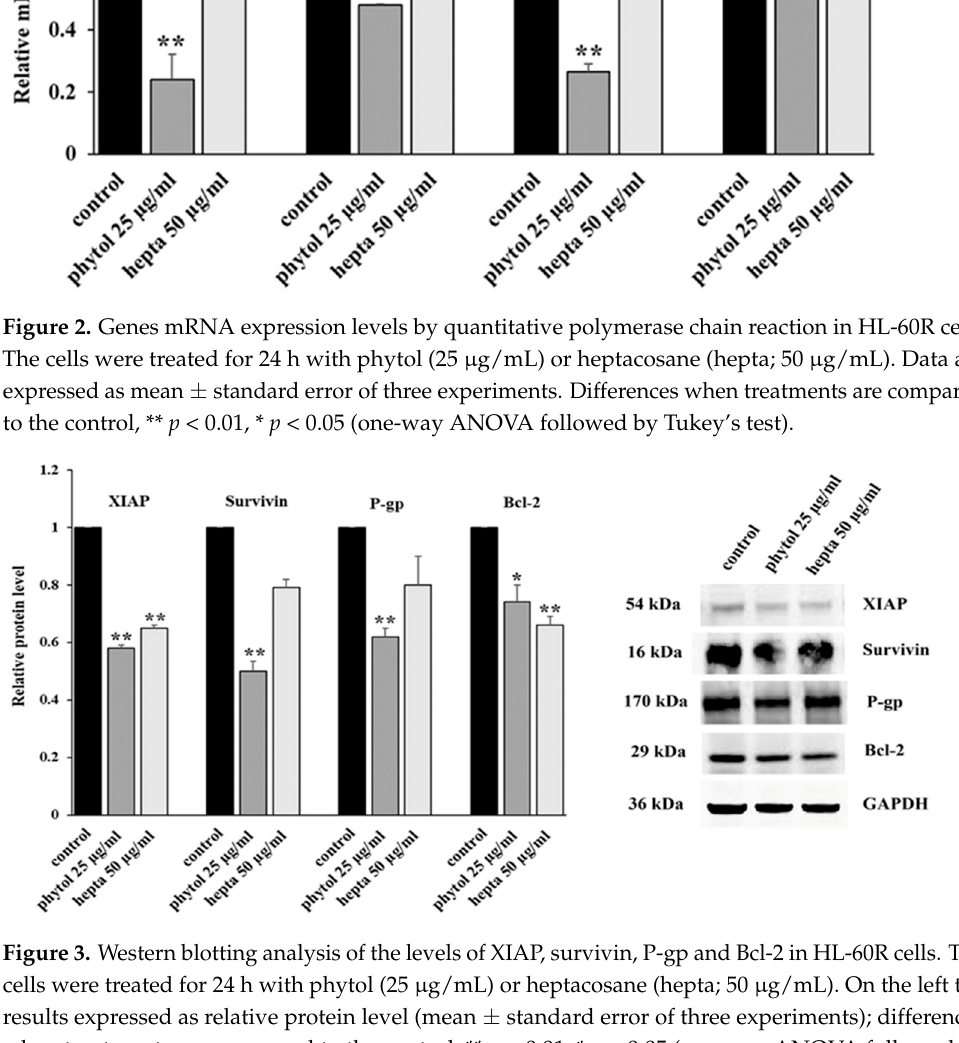
Figure 3. Western blotting analysis of the levels of XIAP, survivin, P-gp and Bcl-2 in HL-60R cells. The cells were treated for 24 h with phytol (25 µg/mL) or heptacosane (hepta; 50 µg/mL). On the left the results expressed as relative protein level (mean ± standard error of three experiments); differences when treatments are compared to the control, ** p < 0.01, * p < 0.05 (one-way ANOVA followed by Tukey’s test). On the right, the results of a representative experiment. Irrelevant parts of the gel image (such as blank lanes and lanes with molecular weight markers) are deleted. The samples were derived from the same experiment and that gels/blots were processed in parallel.